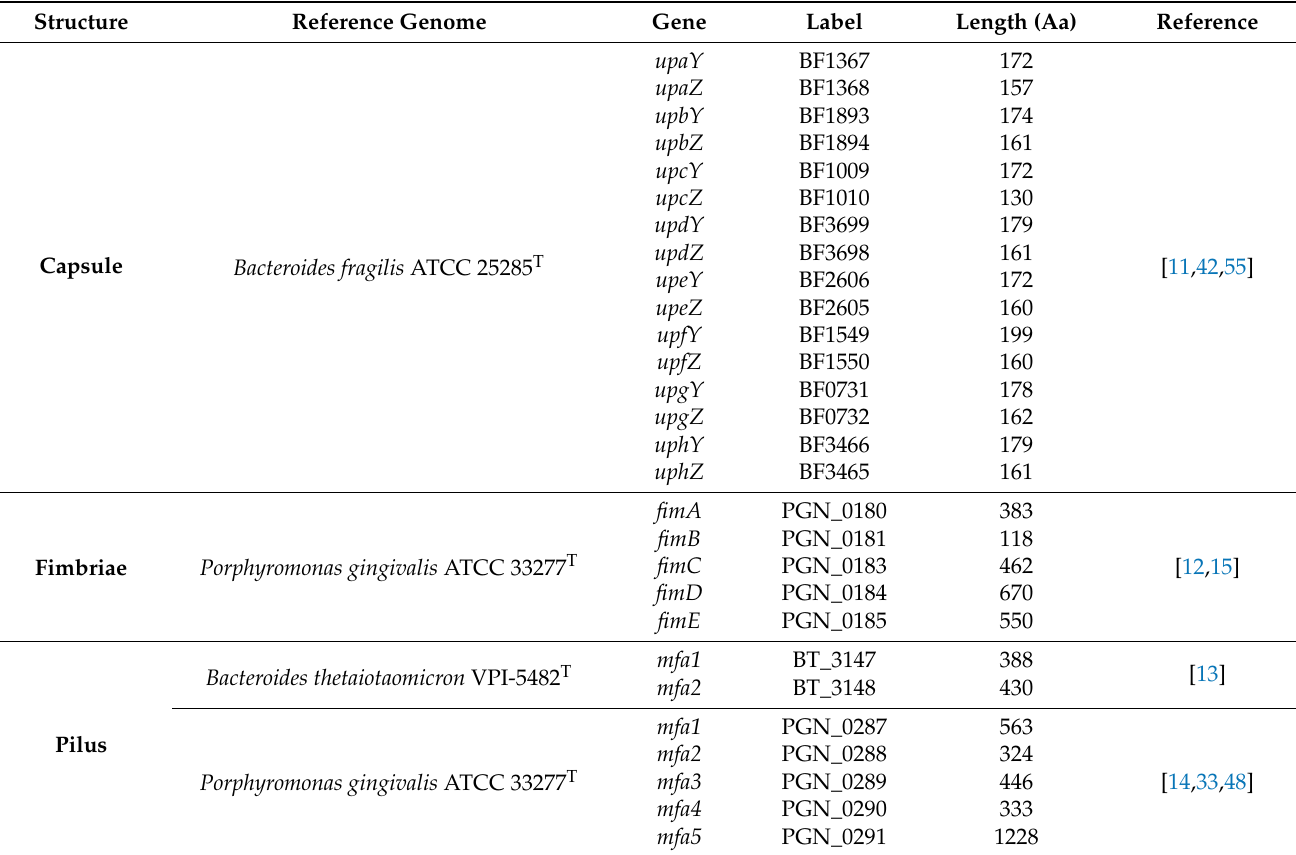
Table 5. Reference genes used to determine external structures of P.